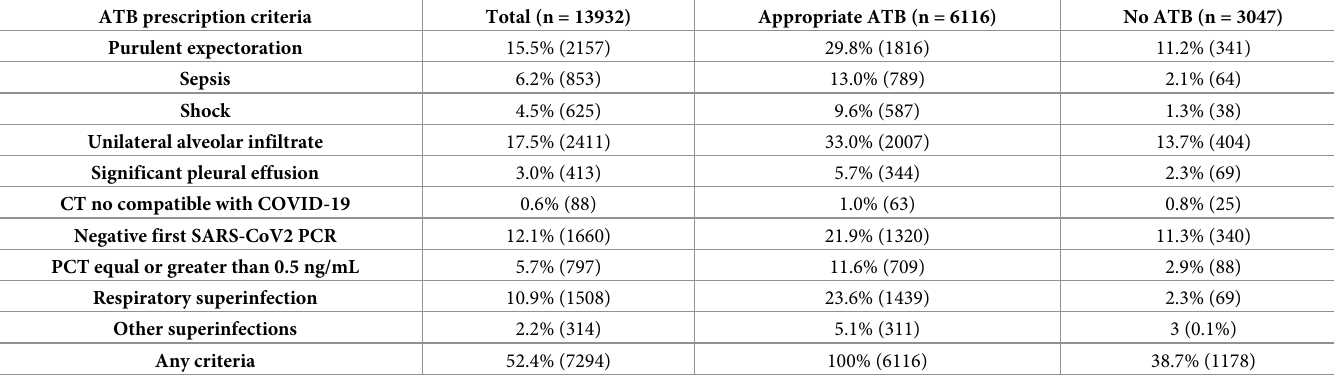
Table 1. ATB prescription criteria in COVID-19